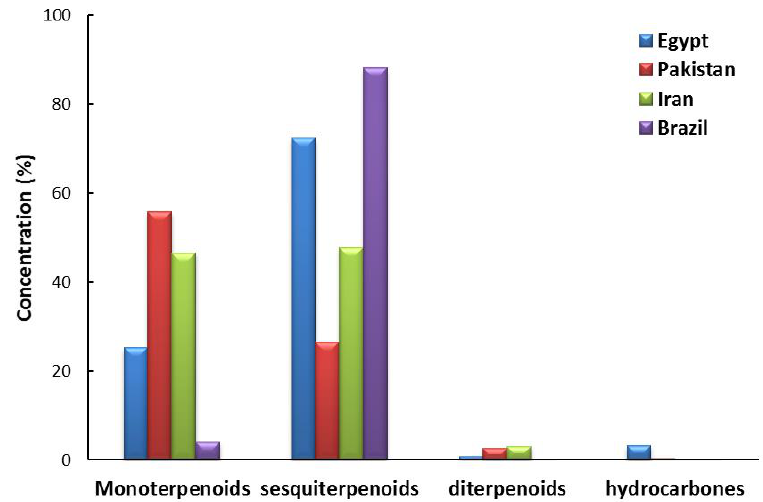
Figure 2. Percentage of various classes of the identified components in EOs from the leaves of X. strumarium from Egypt, as well as those reported from Pakistan [24], Iran [23,25], and Brazil [31].